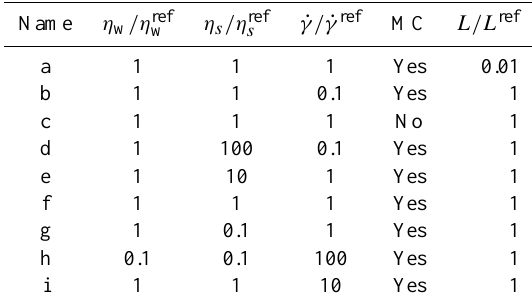
Table 1. Parameters for the models represented in Fig. 9; MC = Mohr–Coulomb